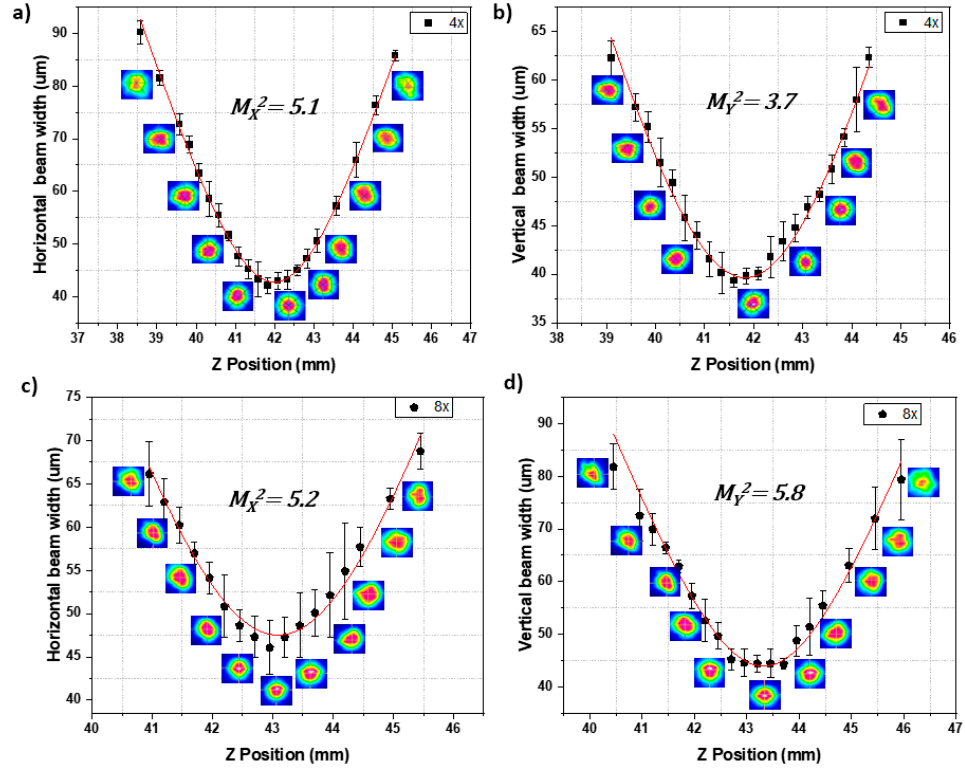
Figure 6. Results of M x2 and M y2 at 632 nm for the different parameters used for the fs laser irradiation for ( a , b ) 4 and ( c , d ) 8 superimposed lines.